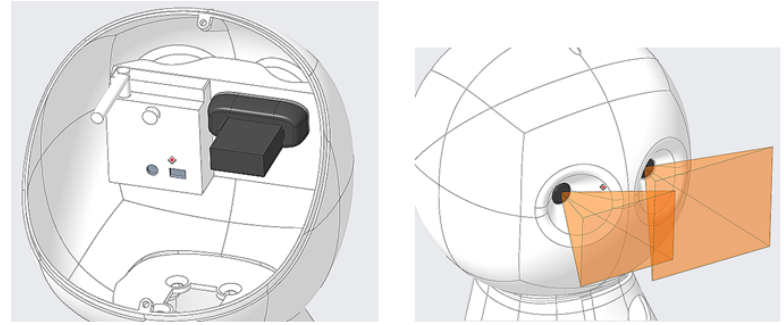
Figure 4. ( Left ) The bottom part of the final head of CLARC showing the camera disposition; and ( Right ) the fields of view of both